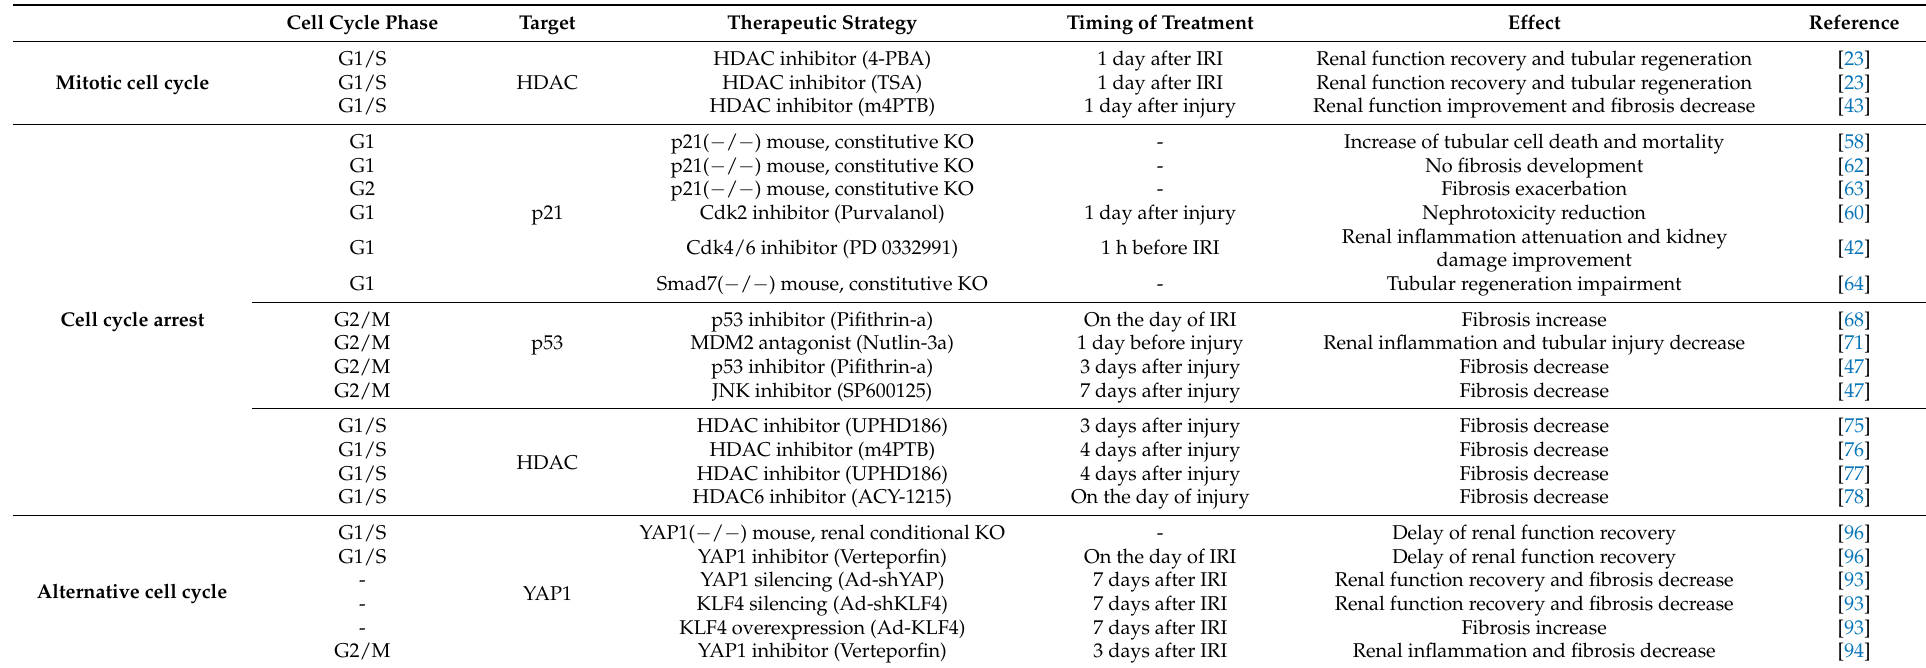
Table 1. Therapeutic strategies based on cell cycle targeting for CKD prevention. IRI: ischemia reperfusion injury; KO: